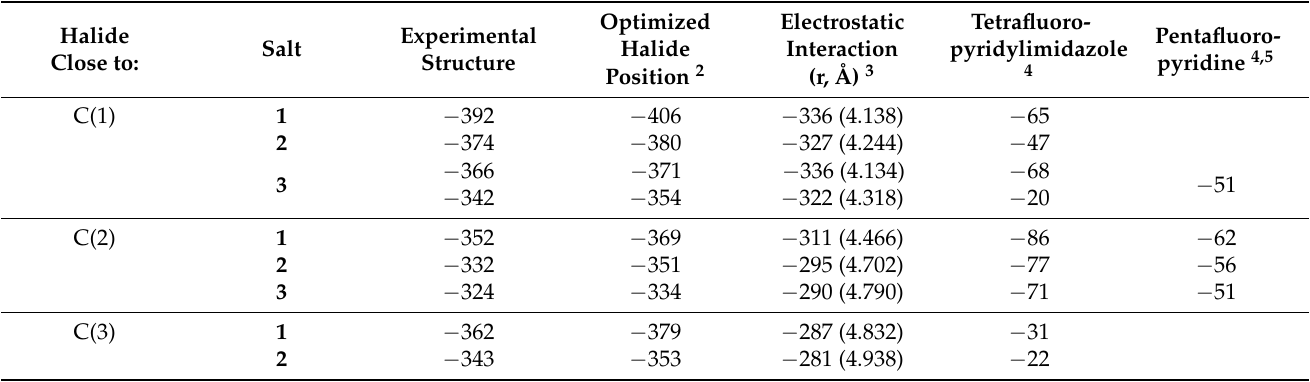
Table 4. Calculated energies of interaction (kJ mol − 1 ) between the halide anion at different positions and the cation of 1-(2,3,5,6-tetrafluoropyridyl)-3-benzylimidazolium chloride 1 , bromide, 2 , and iodide, 3 , and related model systems 1 .